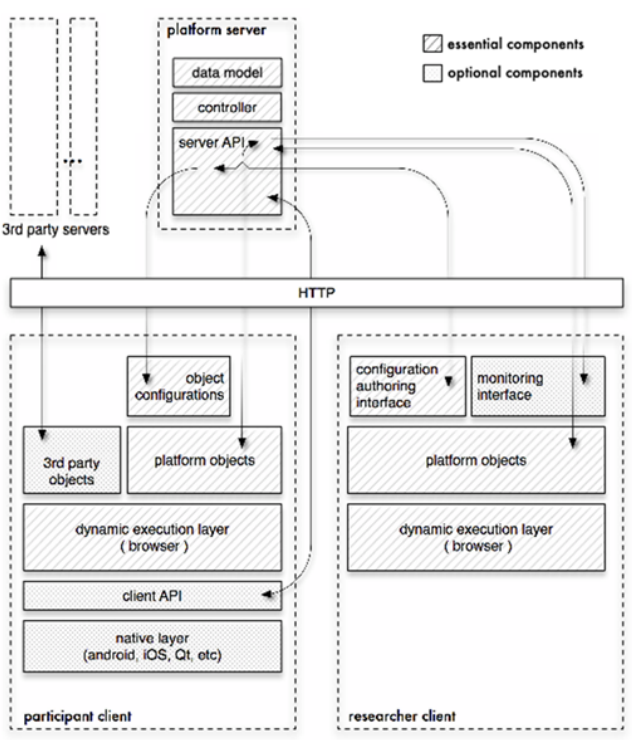
Figure 5. Tempest